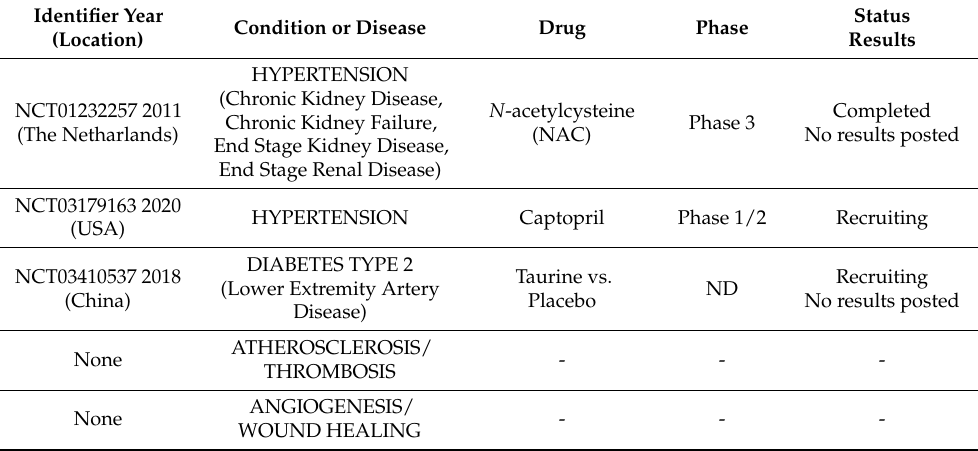
Table 1. Clinical trials on endothelial dysfunction-related diseases with H 2 S